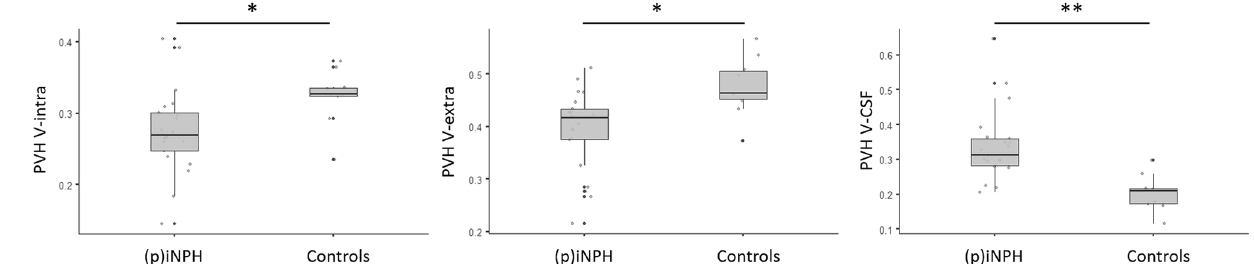
Figure 5. Periventricular cap (PVH) intraaxonal ( A ), extraaxonal ( B ) and CSF ( C ) volume fractions in patients with and without imaging features of idiopathic normal pressure hydrocephalus, defined by iNPH Radscale scores of > 6 ((presumed = p) iNPH; n = 21) and < 5 (Controls; n = 10). * p < 0.05, ** p <